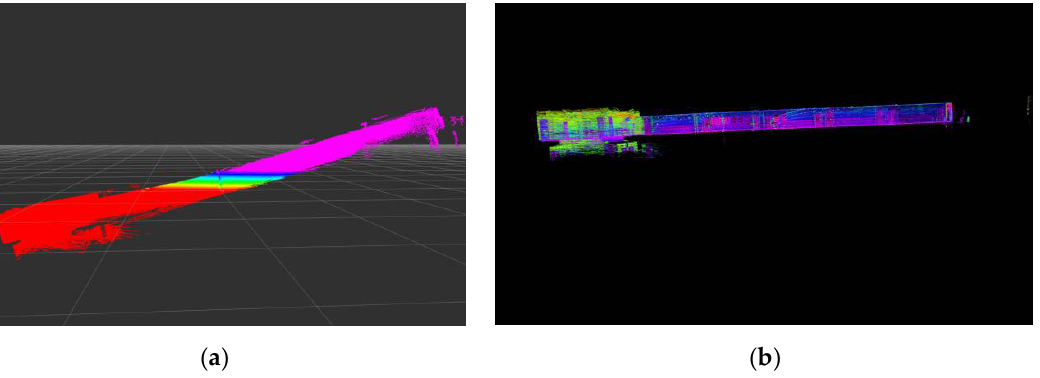
Figure 6. Effect of ground constraints on positioning and map building, they should be listed as: ( a ) Without ground constraint, ( b ) with ground constraint.